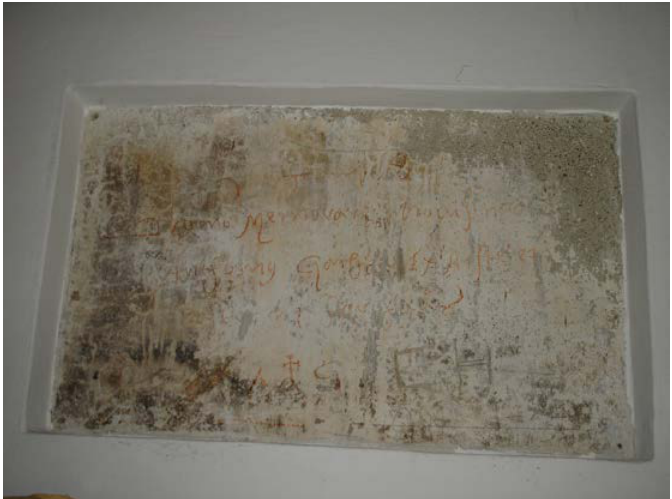
Figure 3 – The graffito of Anton Gachter, a minister from Serfaus, in Berneck Castle, Kauns, Northern Tyrol. Photo by Romedio Schmitz-Esser. Courtesy of the